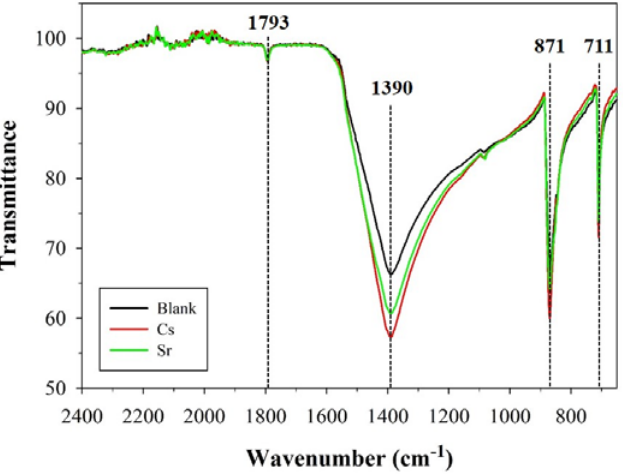
Figure 7. FTIR spectra of the precipitate in each leachate after 90